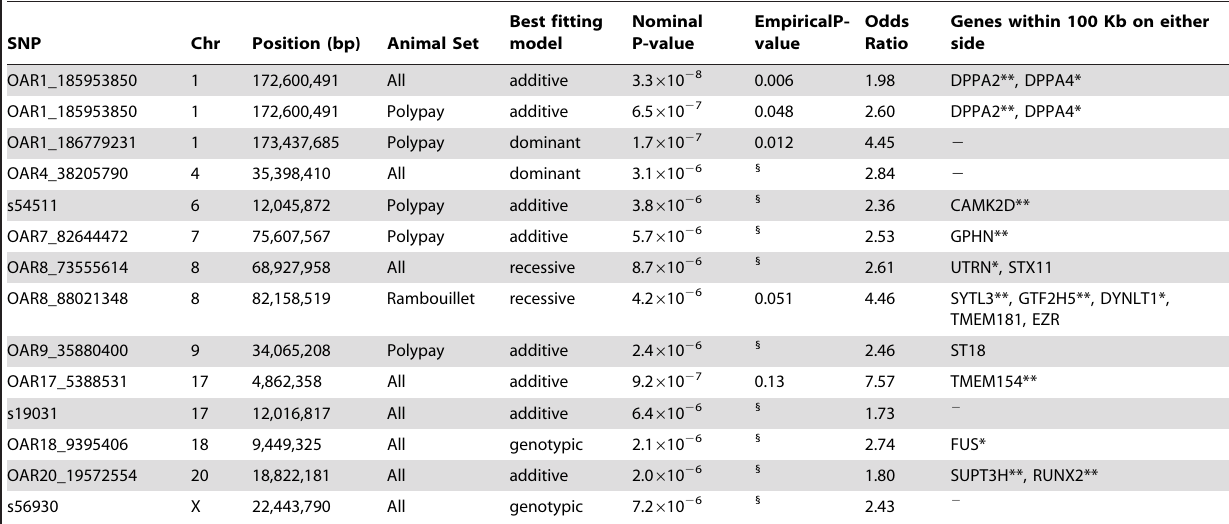
Table 1. Genomic regions associated with susceptibility to OvLV.